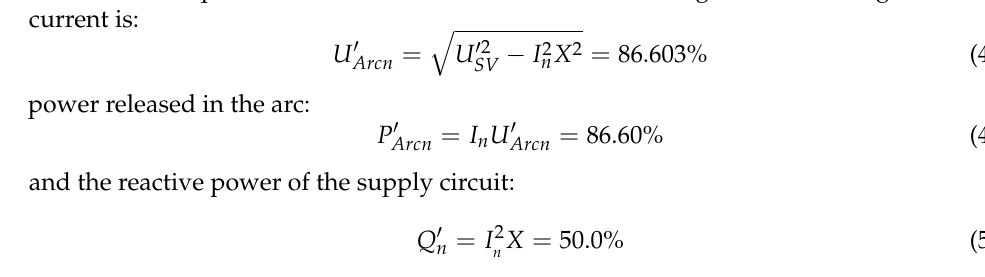
Table 3. Changes in the value of the arc voltage— U Arc , reactive power consumed by the arc-supplying circuit— Q , arc power— P Arc , for different values of the current consumed by the arc device. I U Arc